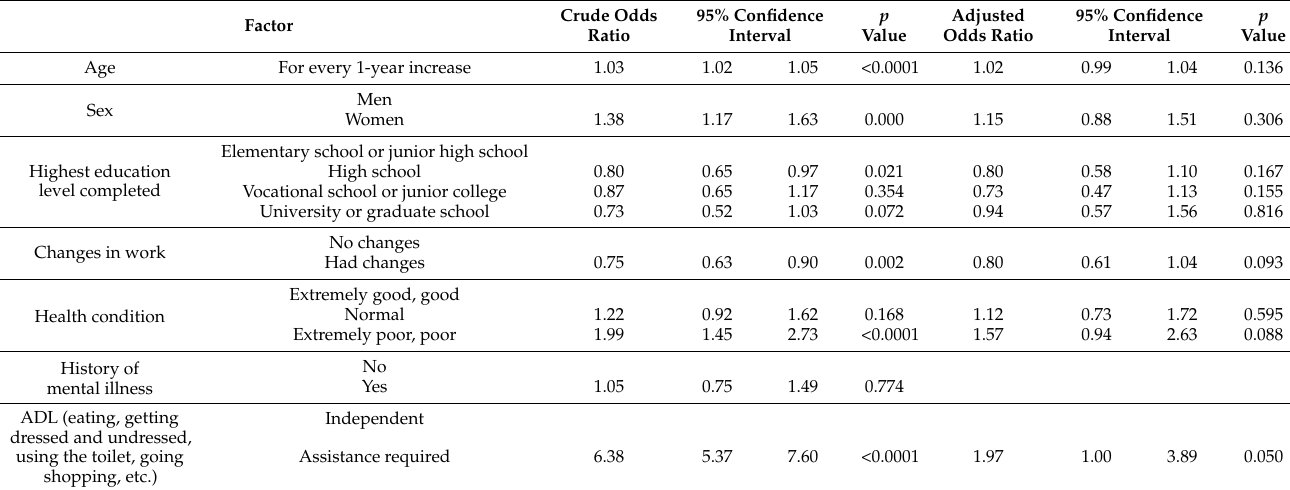
Table 4. Logistic regression analysis of the dependent variables for social nonparticipation among evacuees who relocated to areas outside the Fukushima